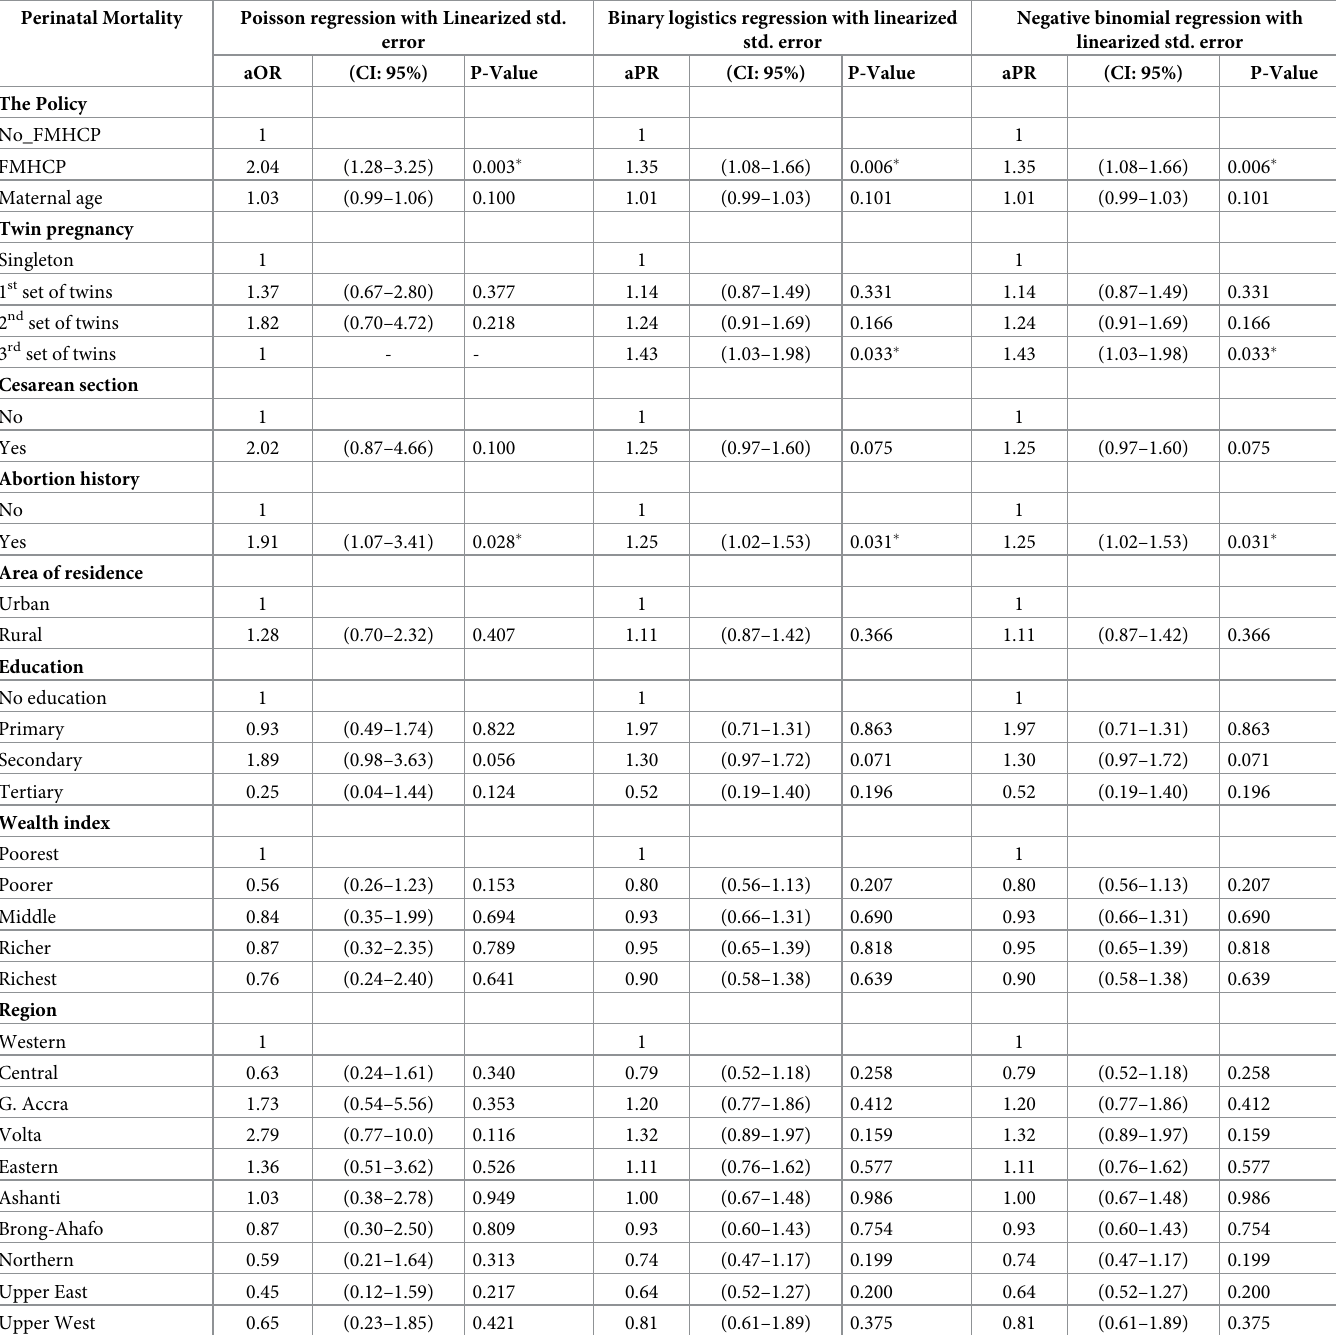
Table 3. Association between the free maternal health care policy and risk of perinatal mortality. Perinatal Mortality Poisson regression with Linearized std.